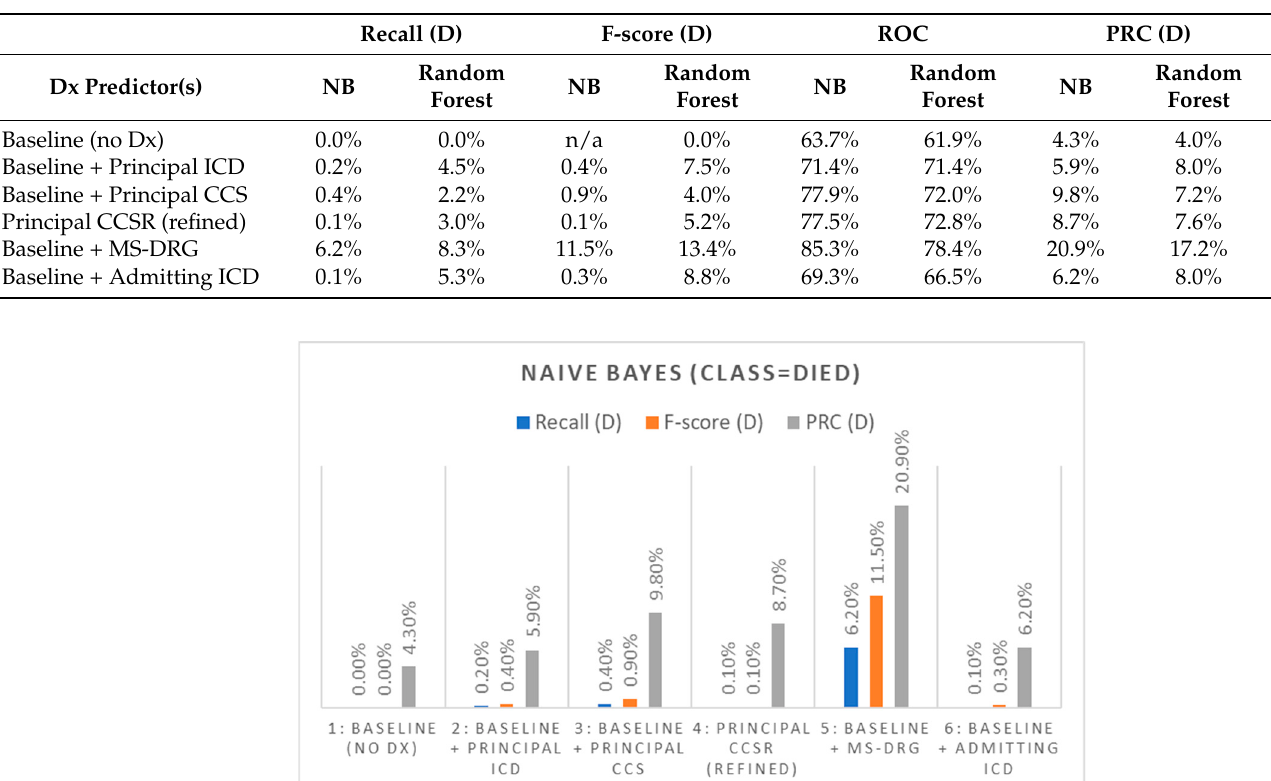
Table 3. Performance of classification experiments with different Dx code systems as predictors for inpatient mortality.